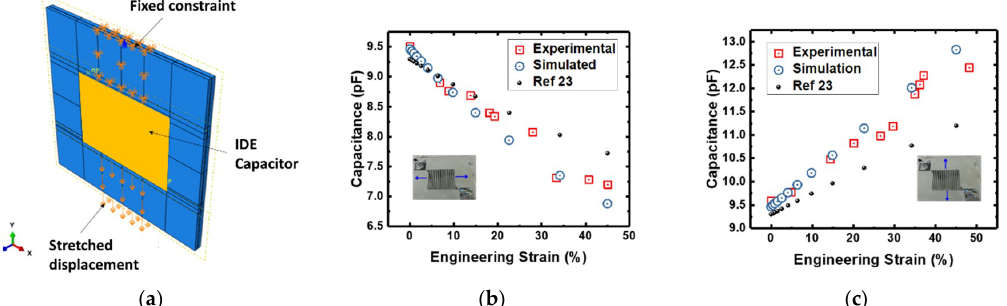
Figure 4 . ( a ) FE simulation model where a fixed constraint was applied to one side and a stretched displacement condition was applied to the other side. Stretching in both x- and y-axes was simulated.